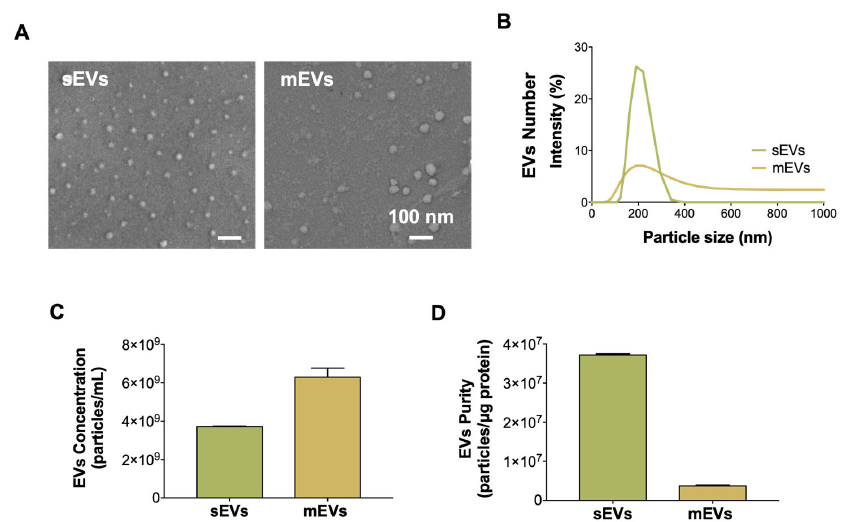
Figure 1. Characterization of platelet-derived EVs. ( A ) SEM images of sEVs and mEVs. Scale bar: 100 nm. ( B ) Representative size distribution of platelet-derived EVs measured using DLS. ( C ) EVs concentration determined by EXOCET assay. ( D ) EVs purity assessed by the number of vesicles to protein concentration